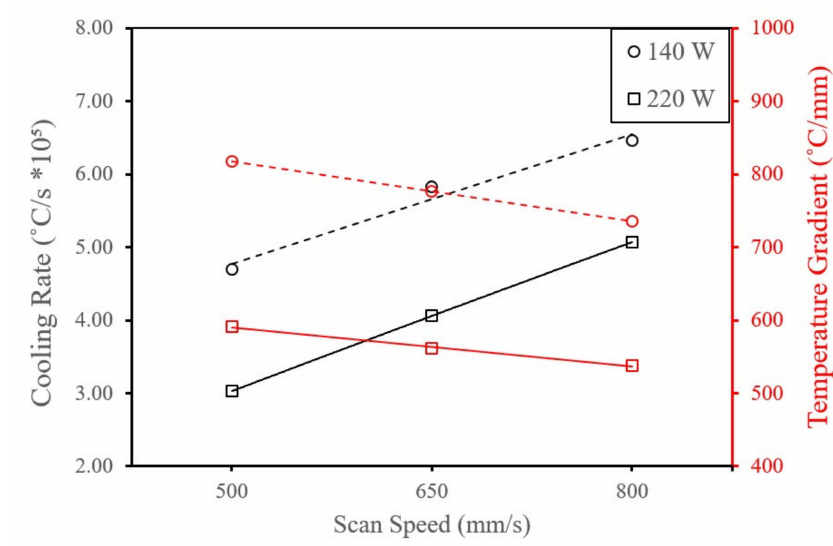
Figure 13. Single tracks CR and temperature